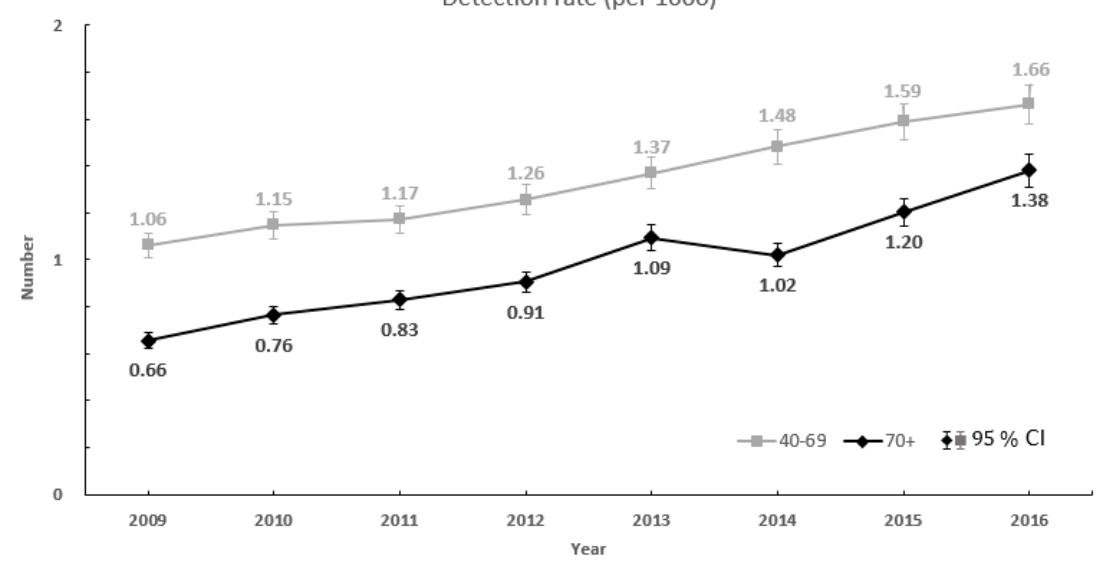
Figure 2. Detection rate of breast cancer by age group, 2009 to 2016.